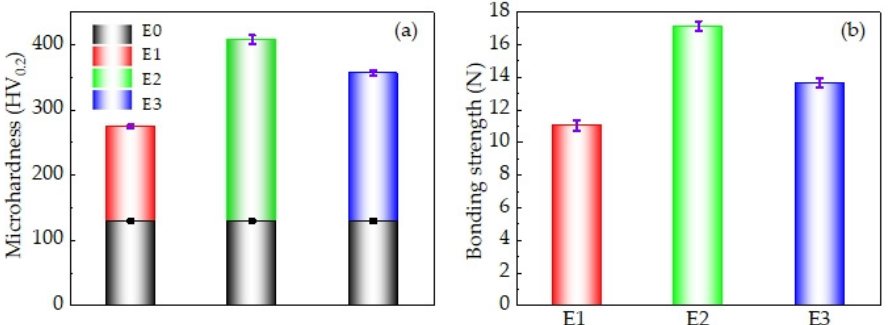
Figure 5. A schematic illustration of electrodeposition process. Figure 6. Mechanical properties of E0, E1, E2 and E3 samples. ( a ) Microhardness; ( b ) bonding strength.